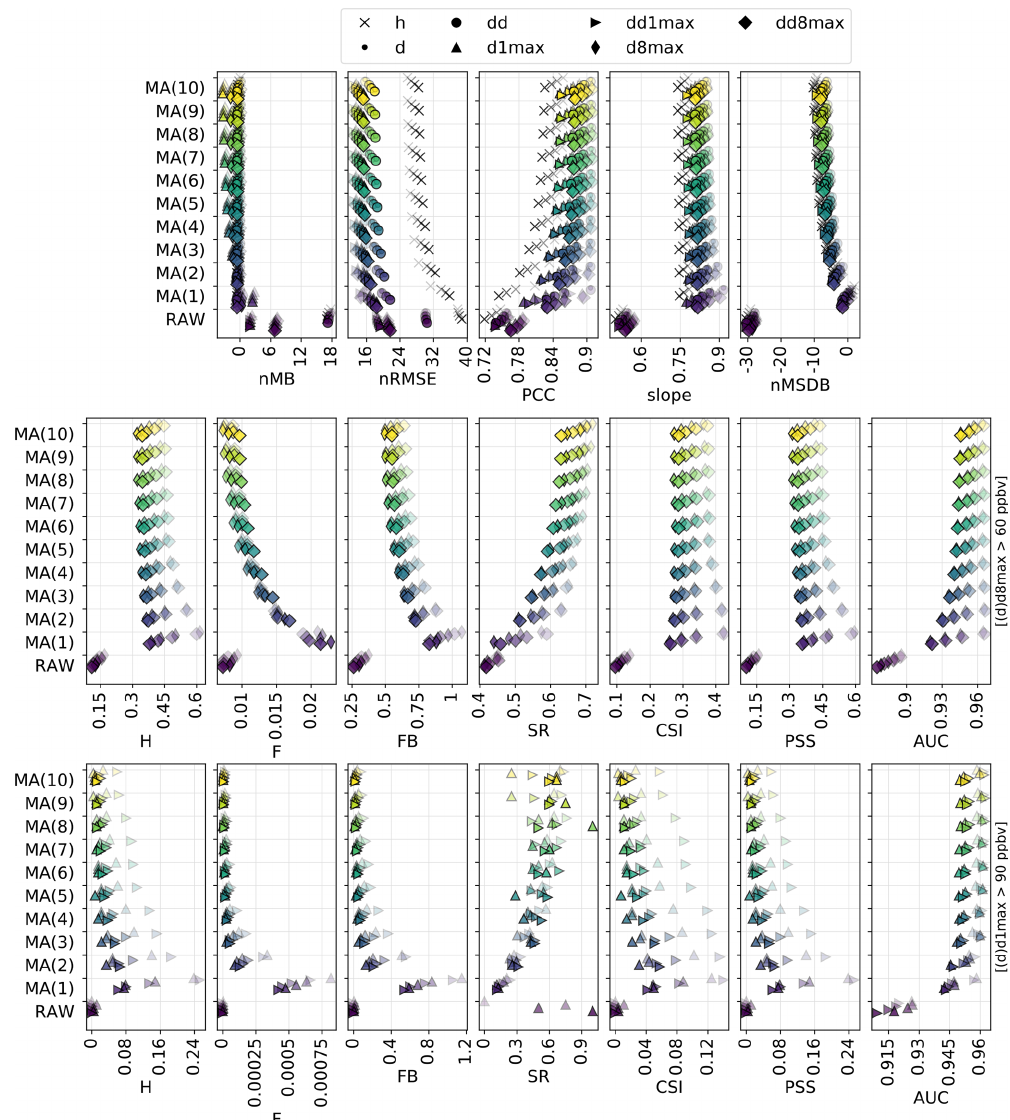
Figure G2. Similar to Fig. 3 for sensitivity tests on the MA method.